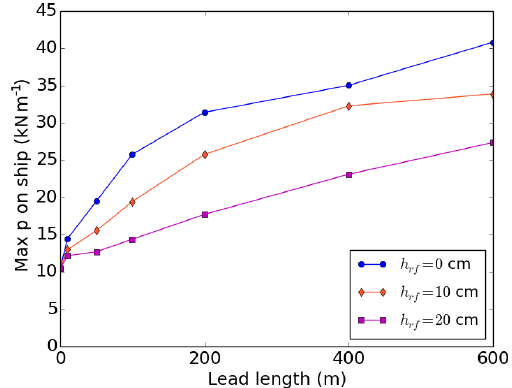
Figure 10. Maximum pressure (kNm − 1 ) on the ship as a function of the length of the lead behind the ship. The thickness field is 2m everywhere except in the lead behind the ship; the thickness of the refrozen lead ( h rf ) is 0cm for the blue curve, it is 10cm for the orange one, and it is 20cm for the magenta one. The digitized ship is 90m long and 30m wide. The normal stresses at the boundaries are − 10kNm − 1 .